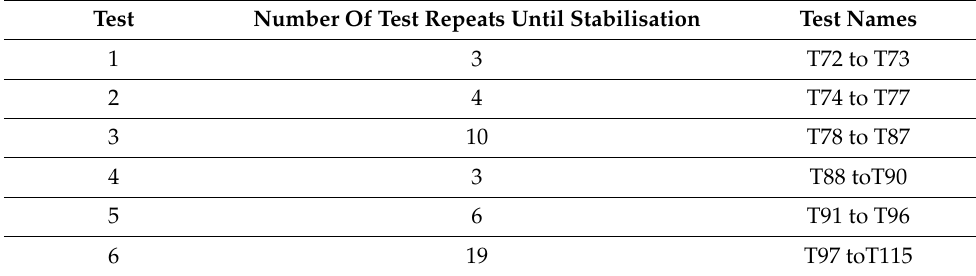
Table 2. Tests conducted during test series A.